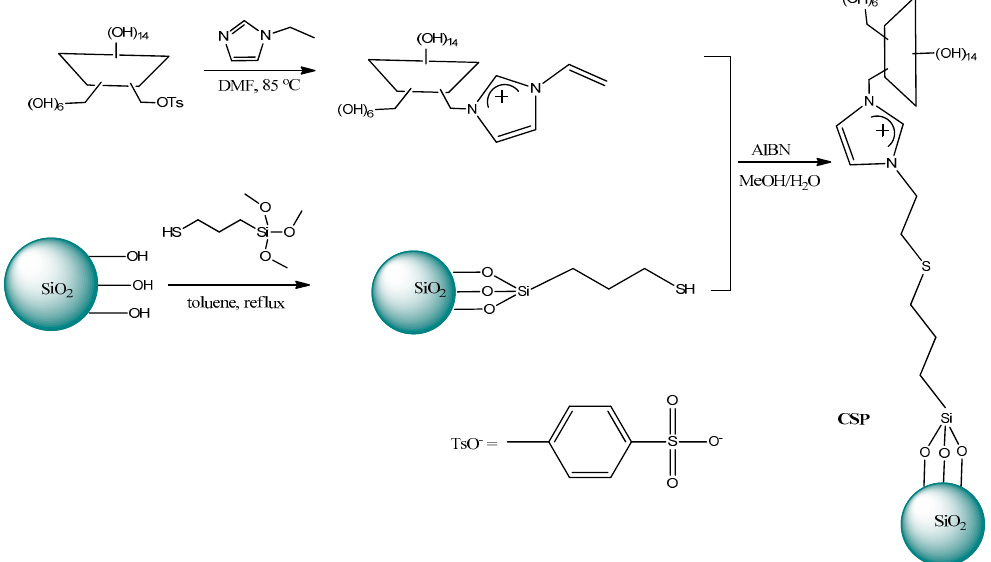
Figure 16. Synthetic pathway of the novel cationic chiral stationary phases (CSPs) (adapted from Yao, 2014) [205].